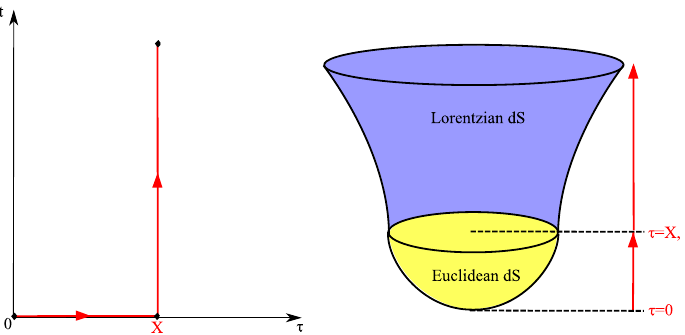
Figure 2. Left : A typical time contour over the complex time, where X = π /2 H 0 . Right : Euclidean and Lorentzian manifold along the given time